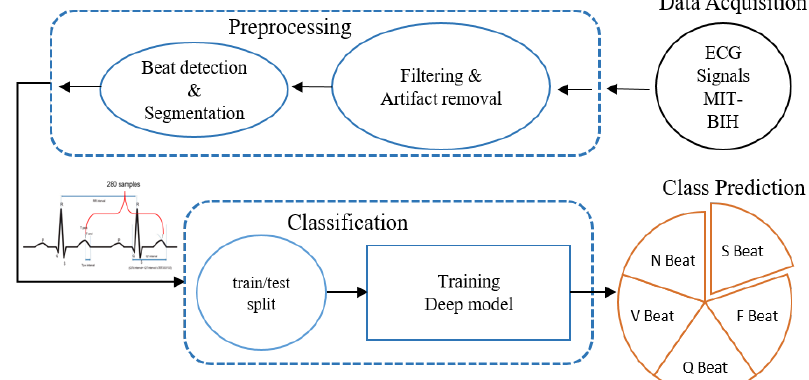
Figure 1. Overview of the heartbeat classification methodology.